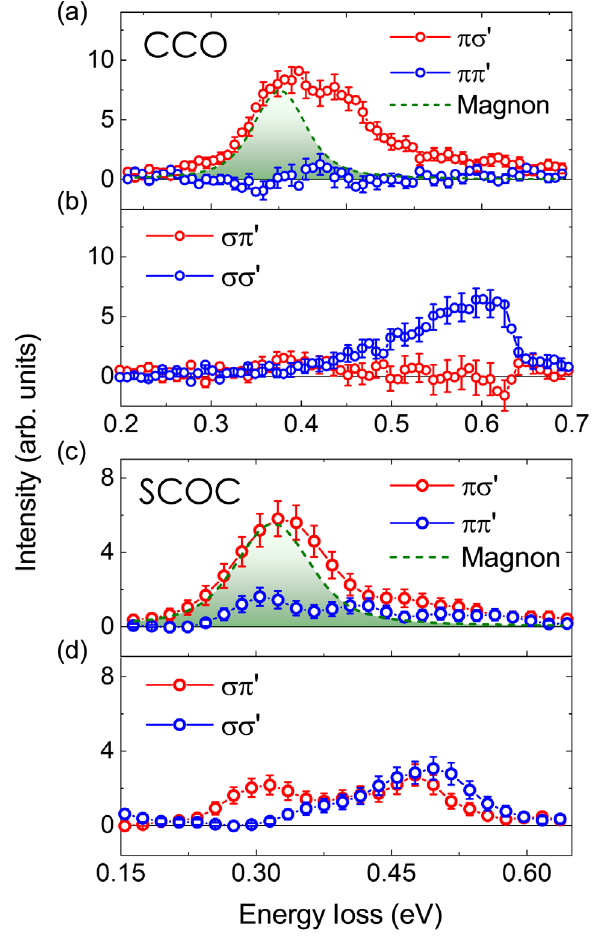
FIG. 5. Polarimetric spectra collected at ð 1 = 2 ; 0 Þ for CCO [panels (a) and (b)] and SCOC [(c) and (d)]. Panels (a) and (c) show the spectra acquired at ( þ 1 = 2 ,0) with incident π polarization, while panels (b) and (d) show the spectra measured with incident σ polarization to maximize the signal coming from non-spin-flip excitations. Blue curves always denote the parallel channel, while red ones show the crossed channel. Note that the resolution of the SCOC data is worse (approximately 65 meV) [17], so the line shape appears to be